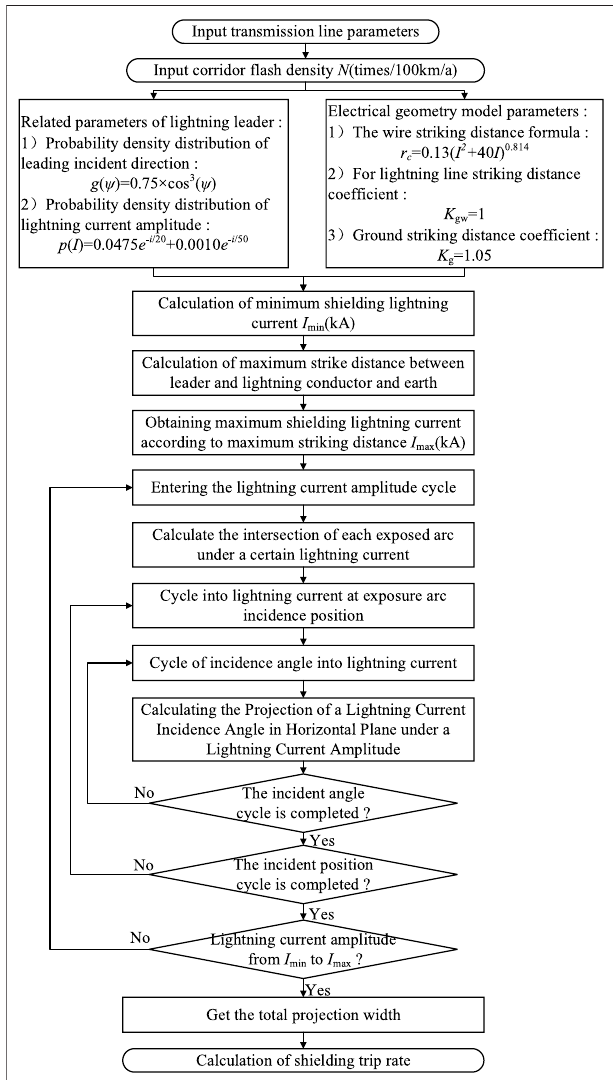
FIGURE 4 | Improved EGM model calculation fl ow